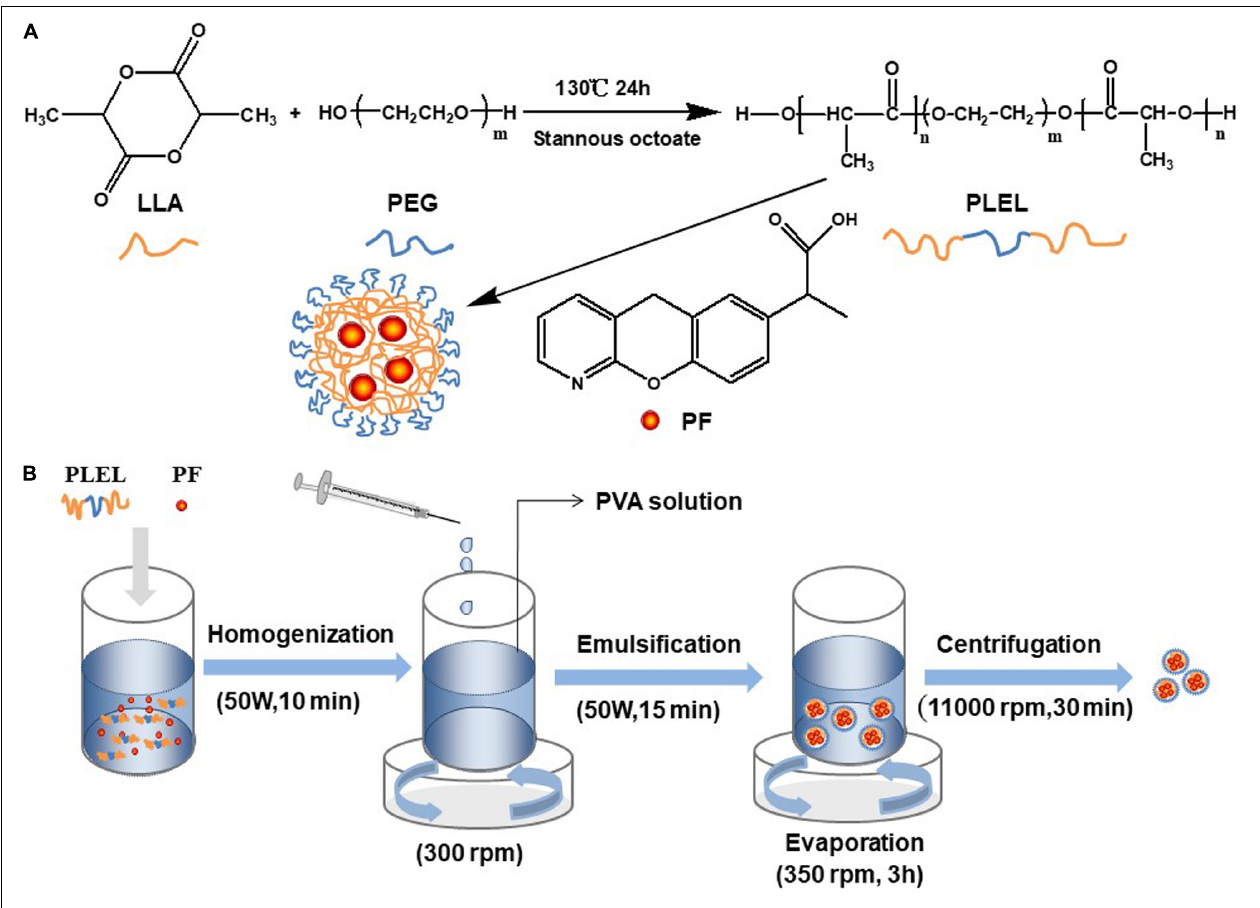
FIGURE 1 | Schematic diagram. (A) PLEL polymerization. (B) PF NPs